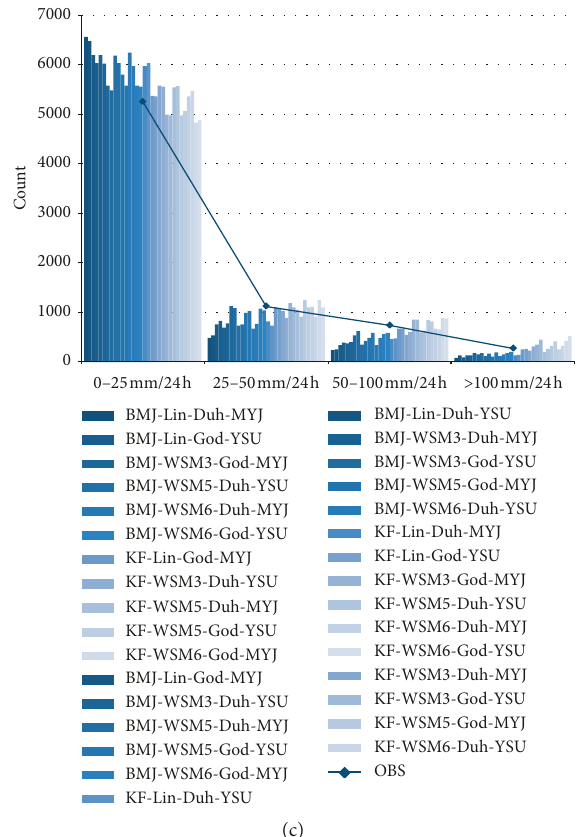
Figure 3: Histogram of daily rainfall frequency at different thresholds (bins) for (a) 24 h, (b) 48h, and (c) 72h forecast ranges. The dotted lines are the observation frequency. The number of samples is 8064 for an individual